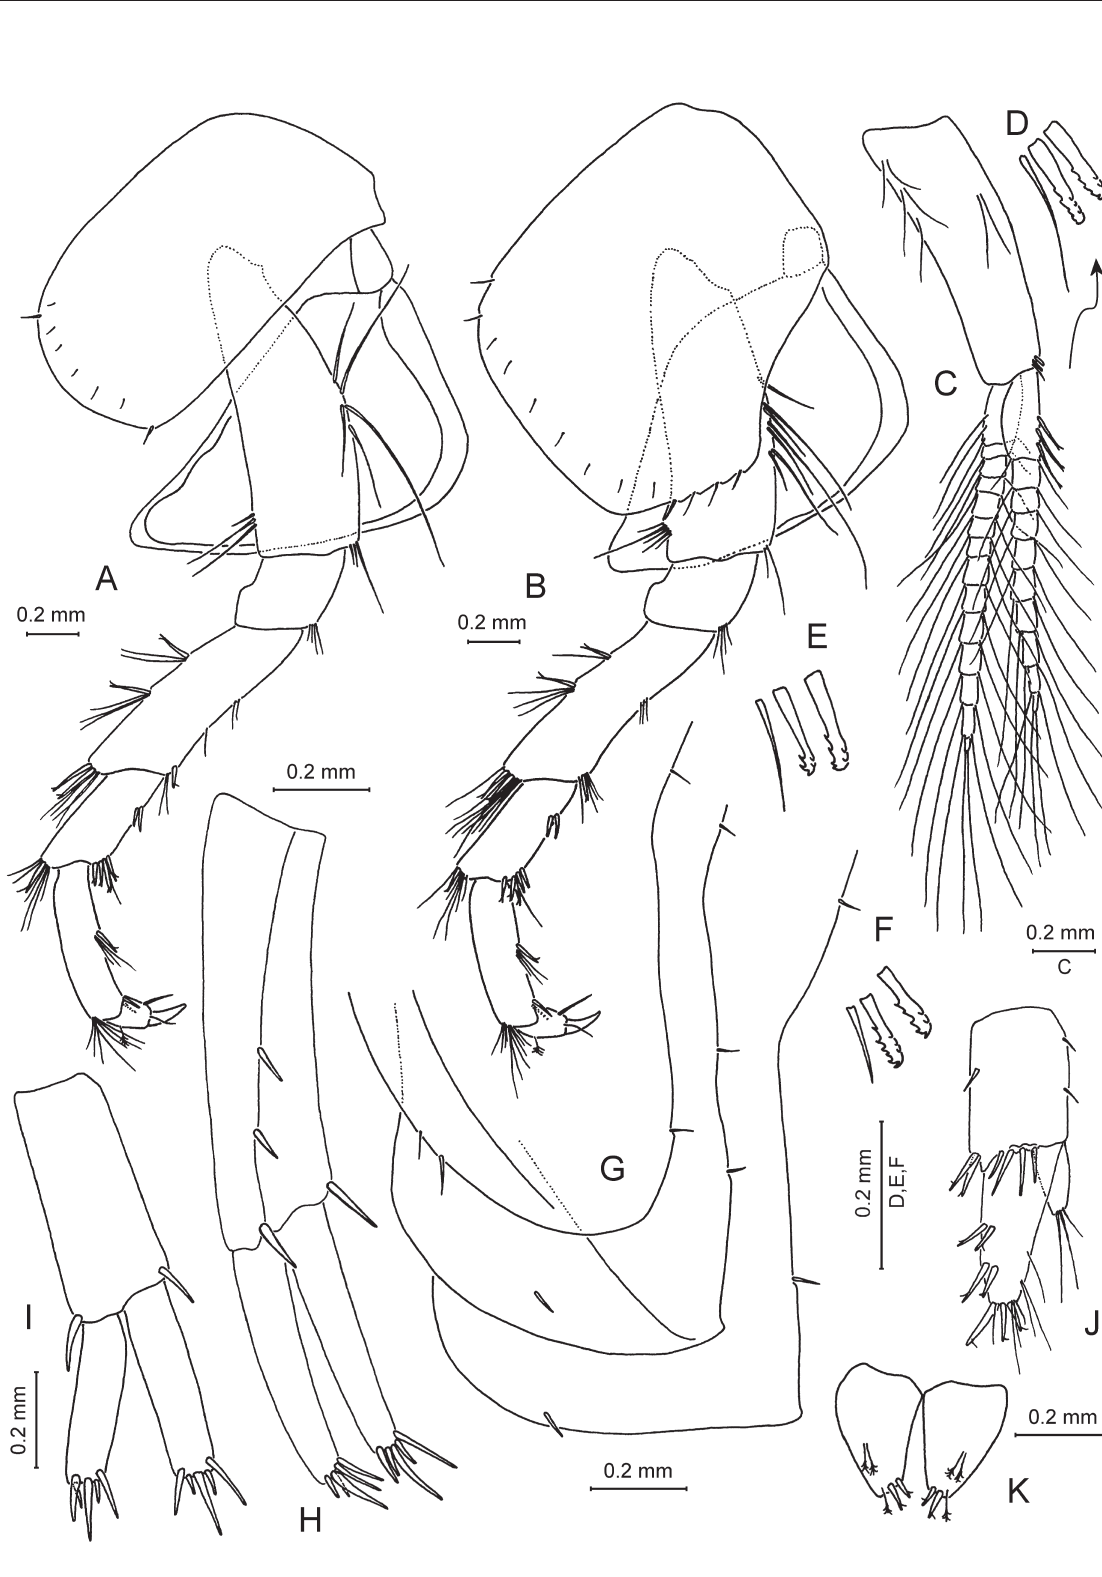
Fig. 9. Zenkevitchia sandroruffoi sp. nov. Holotype, ♂, 8.0 mm, X44041/Cr-1647-FEFU. A . Pereopod 3. B . Pereopod 4. C . Pleopod 1. D–F . Coupling setae of pleopods 1–3. G . Epimeral plates 1–3. H . Uropod 1. I . Uropod 2. J . Uropod 3. K .